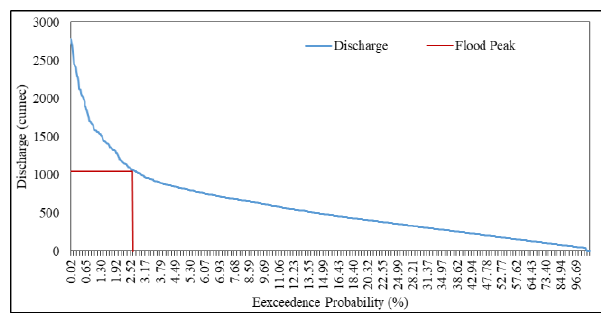
Figure 22 Exceedance probability curve at Nadaun(CORDEX)